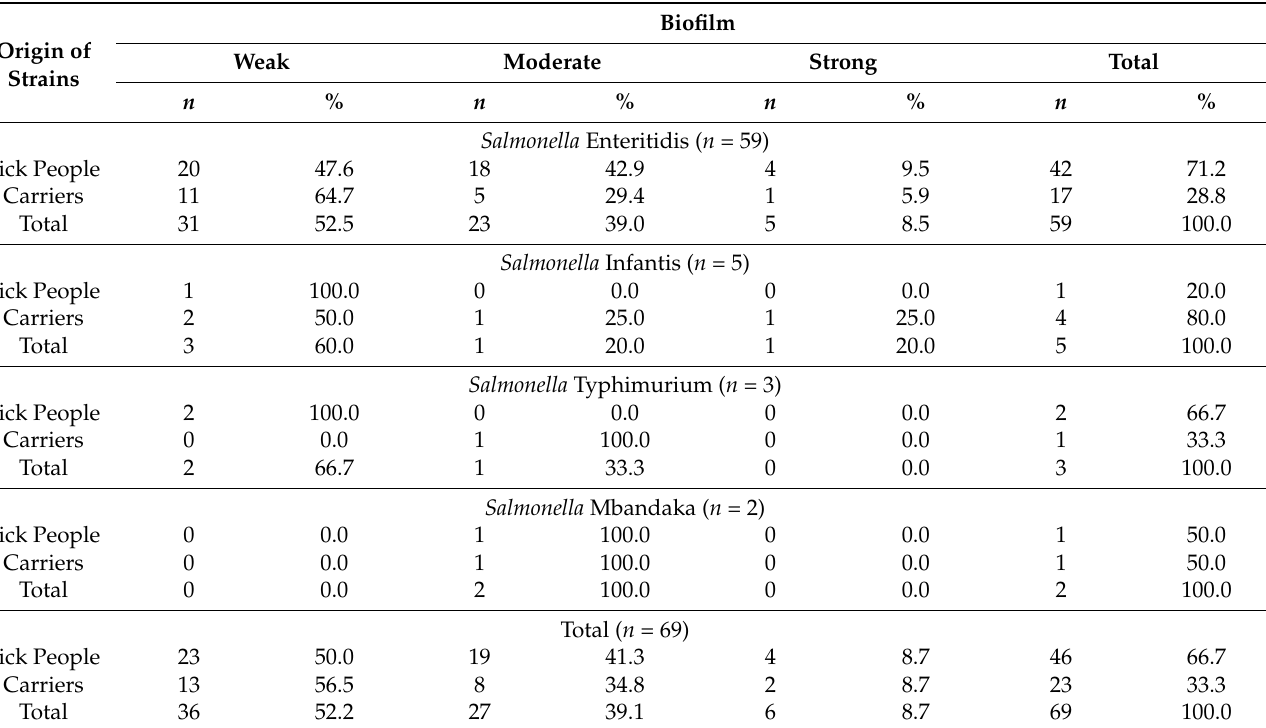
Table 2. Biofilm of S. enterica strains ( n = 69), including